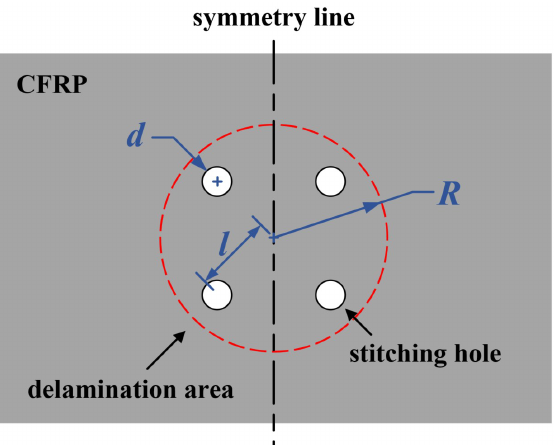
Figure 4. Illustration for the design of repair in which 4 holes are